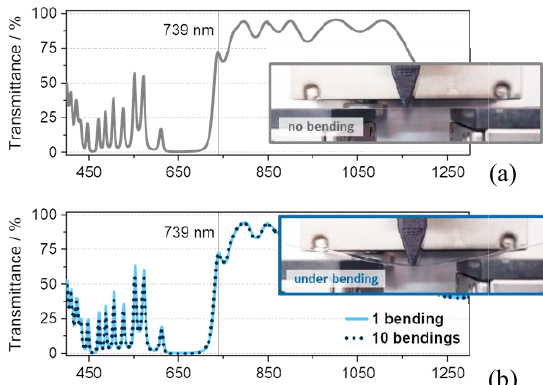
Fig. 1. Picture of the 1D photonic crystal on bending setup a) before and b) during the bending tests (Δd = 2.0 mm). Transmittance spectra of the sample, a) before (grey solid line) and b) after 1 (light blue solid line) and 10 bendings (dark blue dotted line) at a deflection equal to 2.0